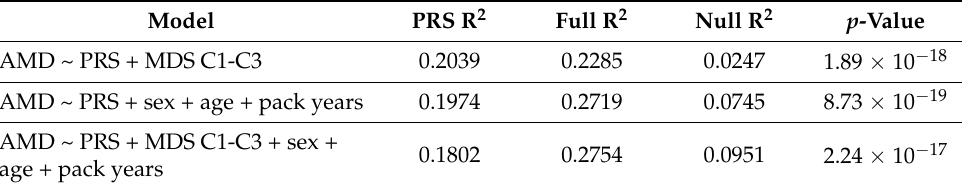
Table 3. Comparison of tested prediction 22-variant models including PRS and (i) the first three genetic multi-dimensional scaling components, (ii) sex, age and smoking status in terms of pack years or (iii) both covariate sets combined.